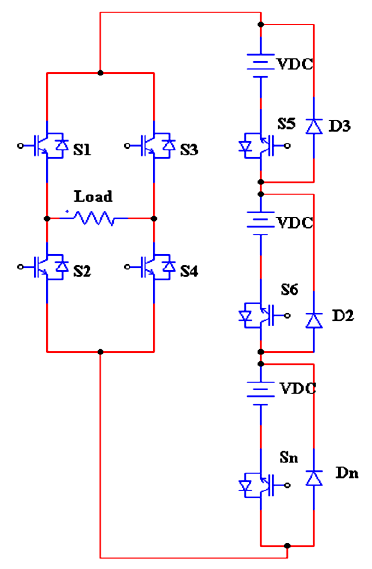
Figure 24. Basic unit and nine-level